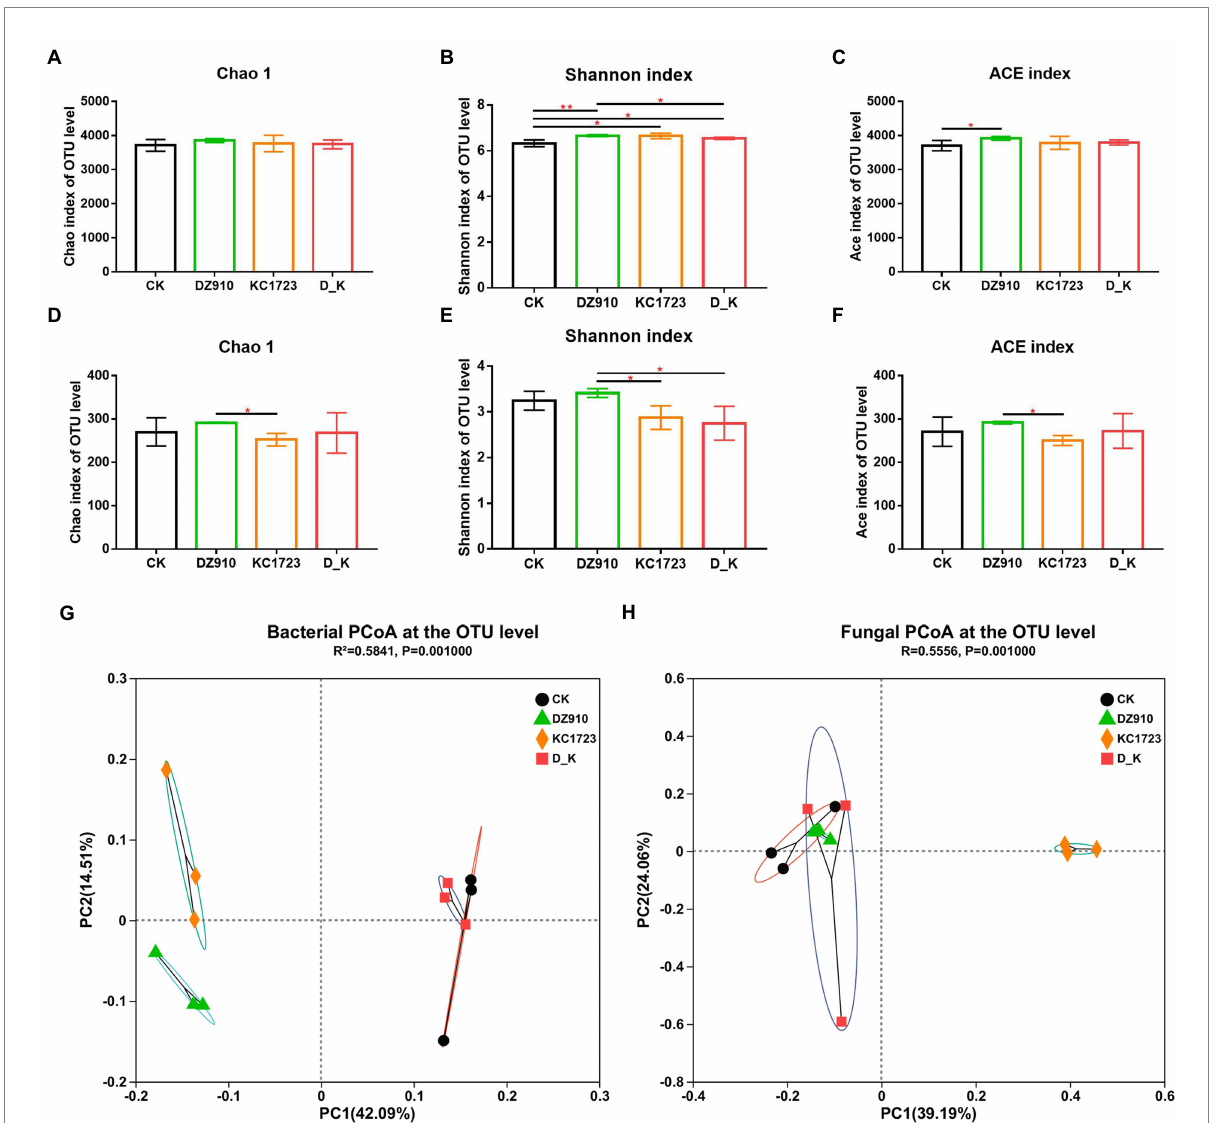
FIGURE 2 Changes in soil microbial alpha and beta diversities. (A–C) bacterial Chao1, Shannon and ACE indices, (D–F) fungal Chao1, Shannon and ACE indices, (G) PCoA clustering analysis of bacteria, (H) PCoA clustering analysis of fungi. Error bars indicate mean ± SE. p -values by T -test indicated significant differences, and the symbol (*) indicated that 0.01 < p ≤ 0.05, (**) indicated that 0.001 < p ≤